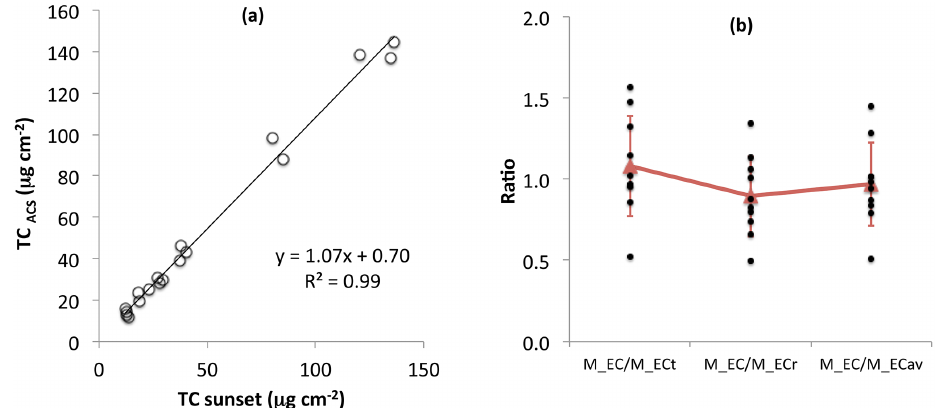
Figure 1. (a) Total carbon concentrations (TC) measured with a thermo-optical method (Sunset Analyzer) and the ACS system (extrac- tion). (b) The ratio of EC concentrations estimated from the ACS system (M_EC), divided by EC from the Sunset Analyzer for three different cases: using transmission correction (M_EC/M_ECt), reflection correction (M_EC/M_ECr) and by the average of M ECr and M ECt (M_EC/M_ECav). The red triangles represent averages over all data points and the error bars 1 standard deviation.